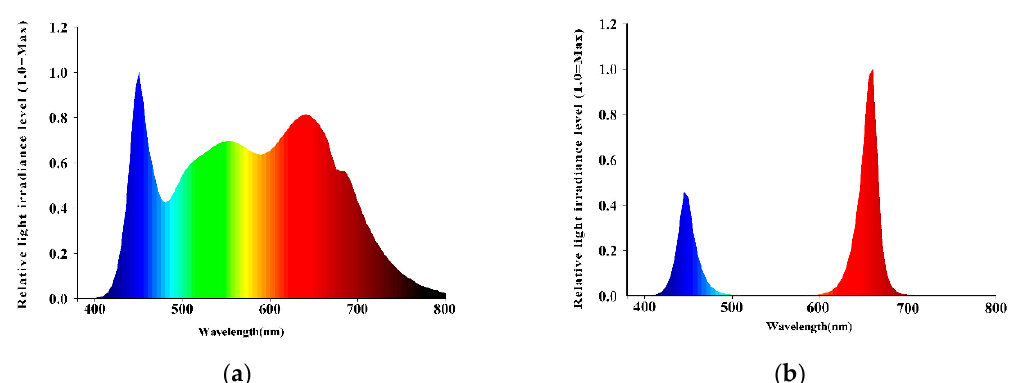
Figure 1. Spectral qualities of the supplementary light sources used in the experiment: ( a ) full-spectrum white LEDs (W); ( b ) red/blue LED light source with a 4:1 ratio (R4:B1).